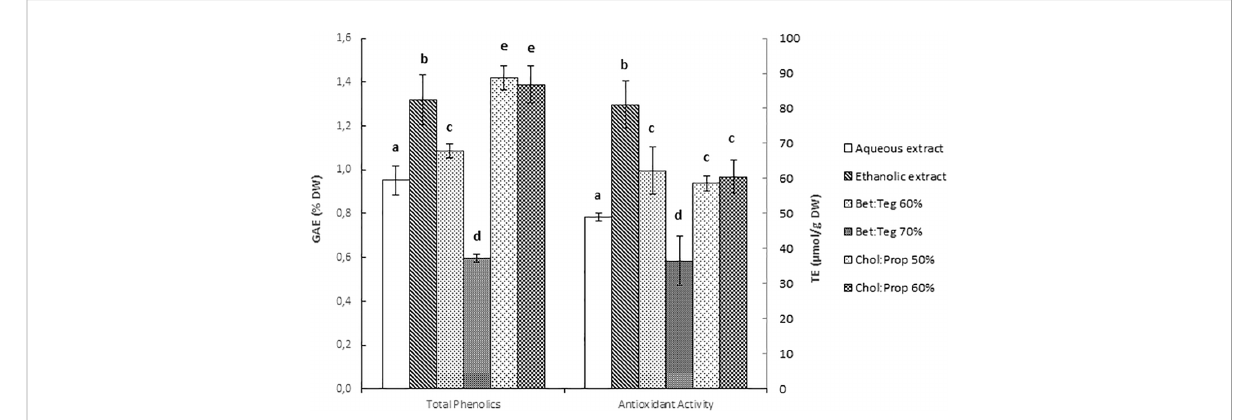
FIGURE 2 Total phenolics (TP) content expressed in gallic acid equivalents (GAE) % of dry weight (DW) and antioxidant activity expressed in Trolox equivalent (TE) µmol/g DW. Letters above error bars stand for statistically signi fi cant differences between